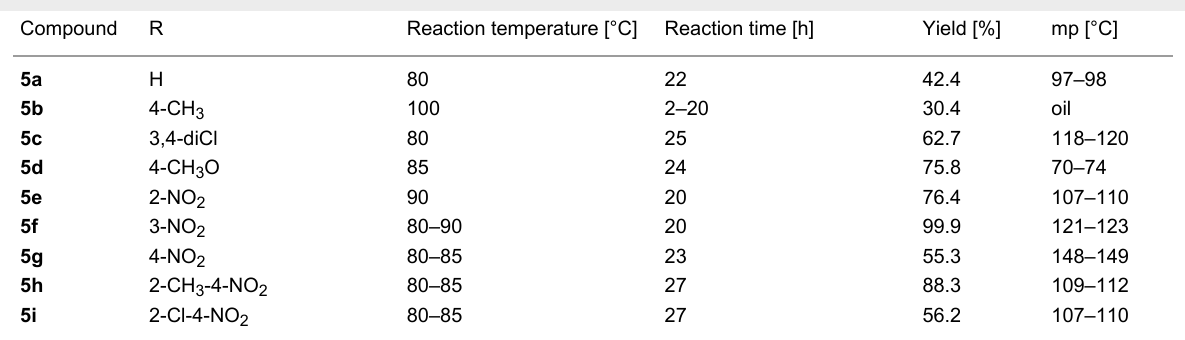
Table 1: Cinnamates bearing a nitroxyl moiety ( 5a – i ).